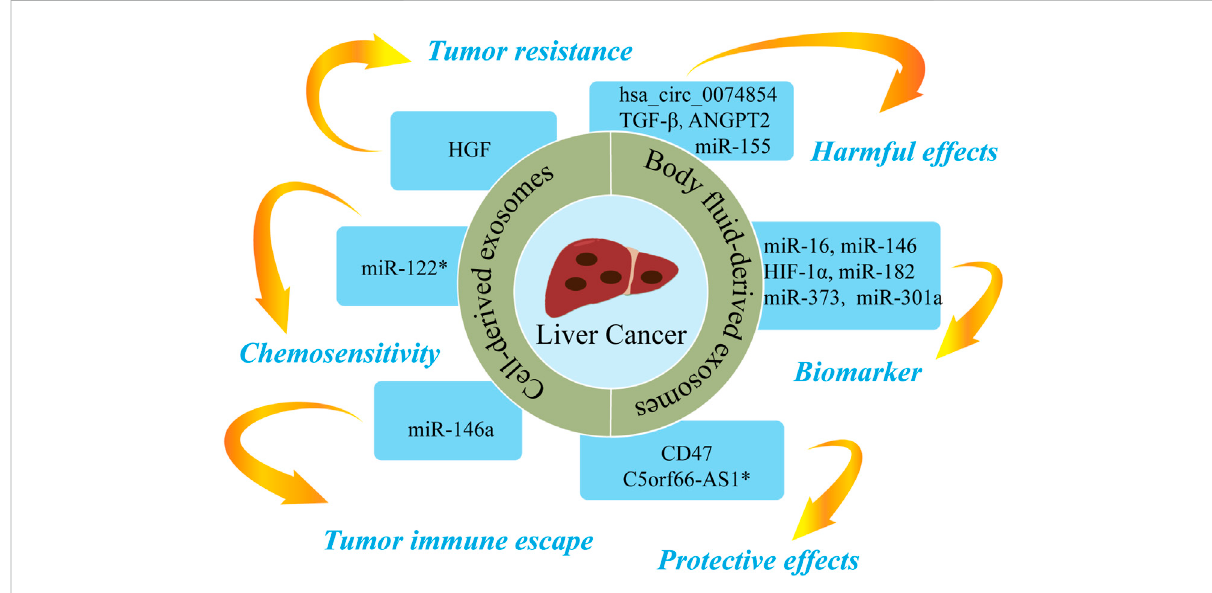
FIGURE 6 The roles of nucleic acids and proteins carried by exosomes in liver cancer. Nucleic acids or proteins carried by exosomes can exert harmful/ protective effects on liver cancer and may also be predictive biomarkers for liver cancer. Some nucleic acids or proteins may be involved in tumor resistance, tumor immune escape, or chemosensitivity. * refers to nucleic acids and proteins carried by exosomes from mesenchymal stem